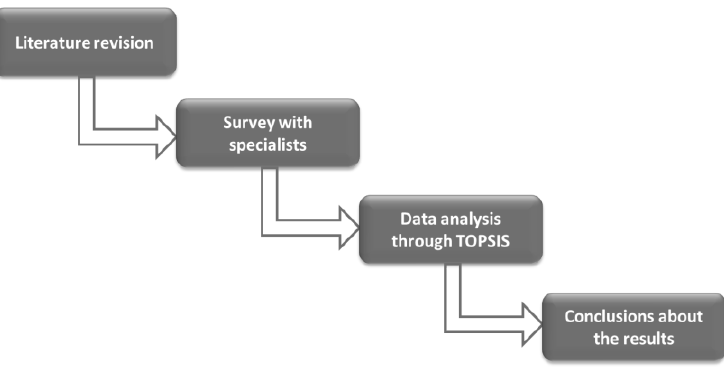
Figure 1. Search steps. Source: Authors (2022).